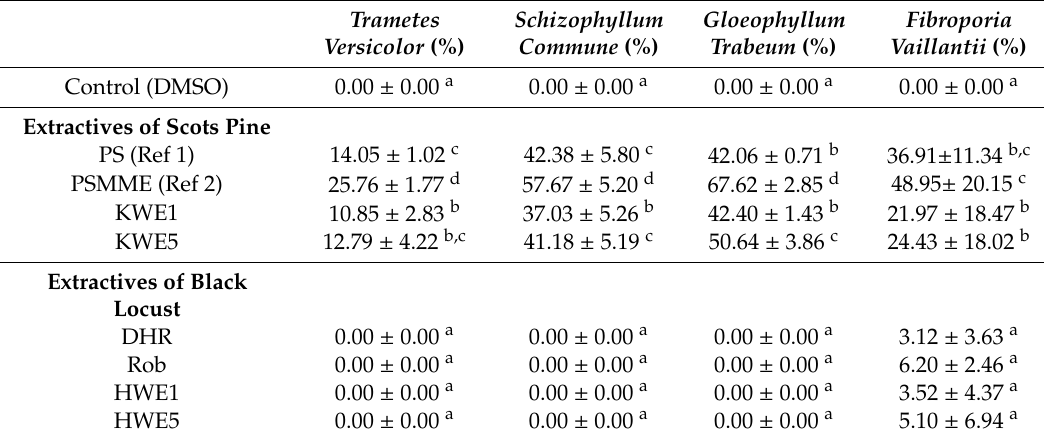
Table 3. Fungal growth inhibition (FI, %) of white-rot and brown-rot-producing fungi by pure compounds (PS, PSMME, DHR and Rob) and HWE and